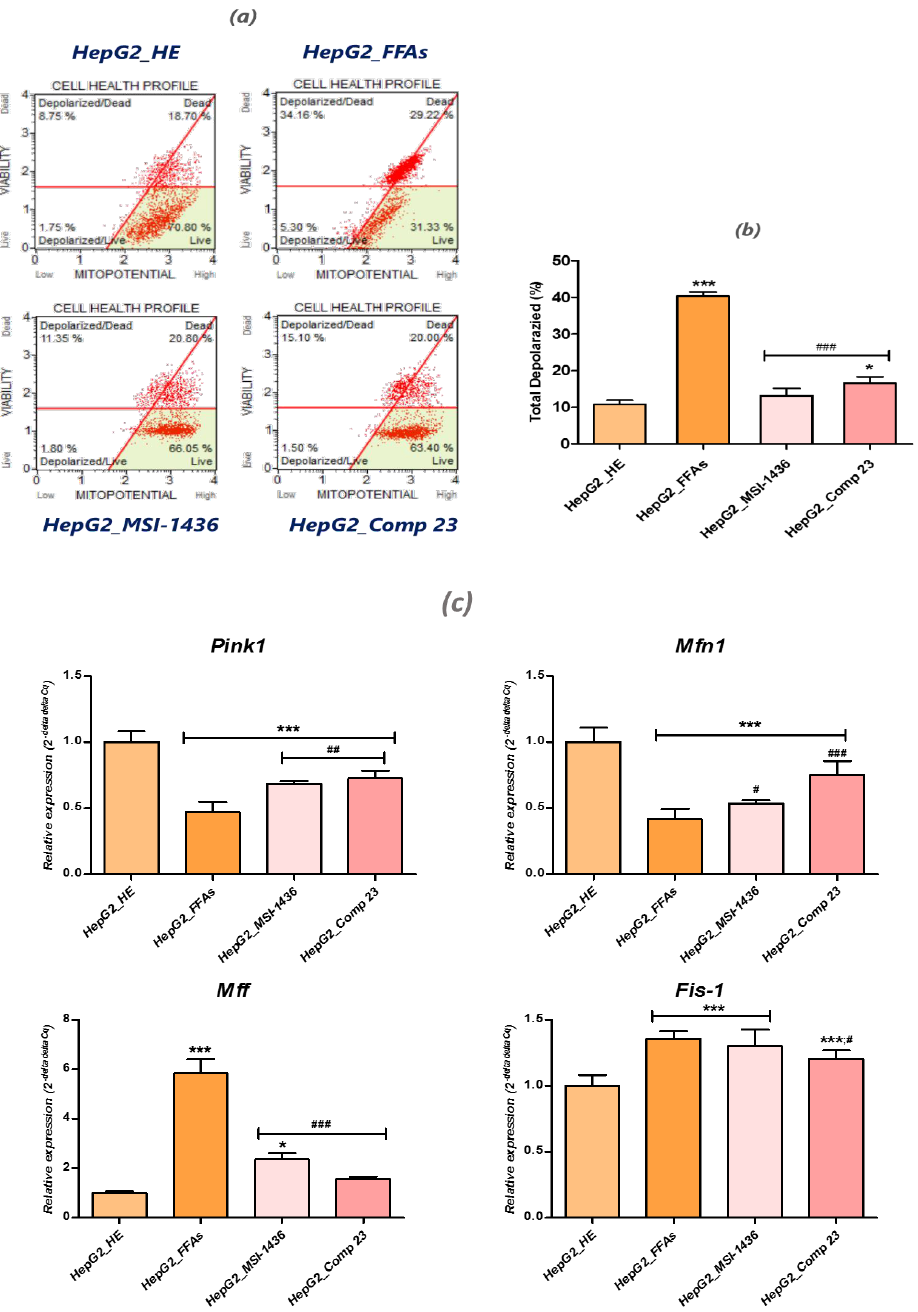
Figure 4. Changes in the mitochondrial dynamic assessment in FFA-challenged HepG2 cells in the presence or absence of MSI-1436 and compound 23 PTP inhibitors. ( a ) A scattered blot representation of the cellular mitochondrial health profile for one representative experiment. ( b ) Bar-charts represent the average percentages ± SD for the total depolarized cells of three repetitions. ( c ) Histograms summarize the relative expression of mitochondrial fusion and fission regulators. Representative data from three independent experiments are shown as mean ± SD ( n = 3). An asterisk (*) refers to a comparison of all treated groups to untreated healthy cells. A hashtag (#) indicates a comparison of the PTP inhibitor treated groups to FFA-challenged cells. * / #, p < 0.05, *** / ###, p < 0.001. HepG2_HE: HepG2 healthy untreated cells; HepG2_FFAs: HepG2 cells exposed to the palmitate / oleate combination; HepG2_MSI-1436: HepG2 cells pre-treated with 1 µ M MSI-1436 inhibitor and exposed to the palmitate / oleate combination; HepG2_Comp 23: HepG2 cells pre-treated with 1 µ M compound 23 inhibitor and exposed to the palmitate / oleate